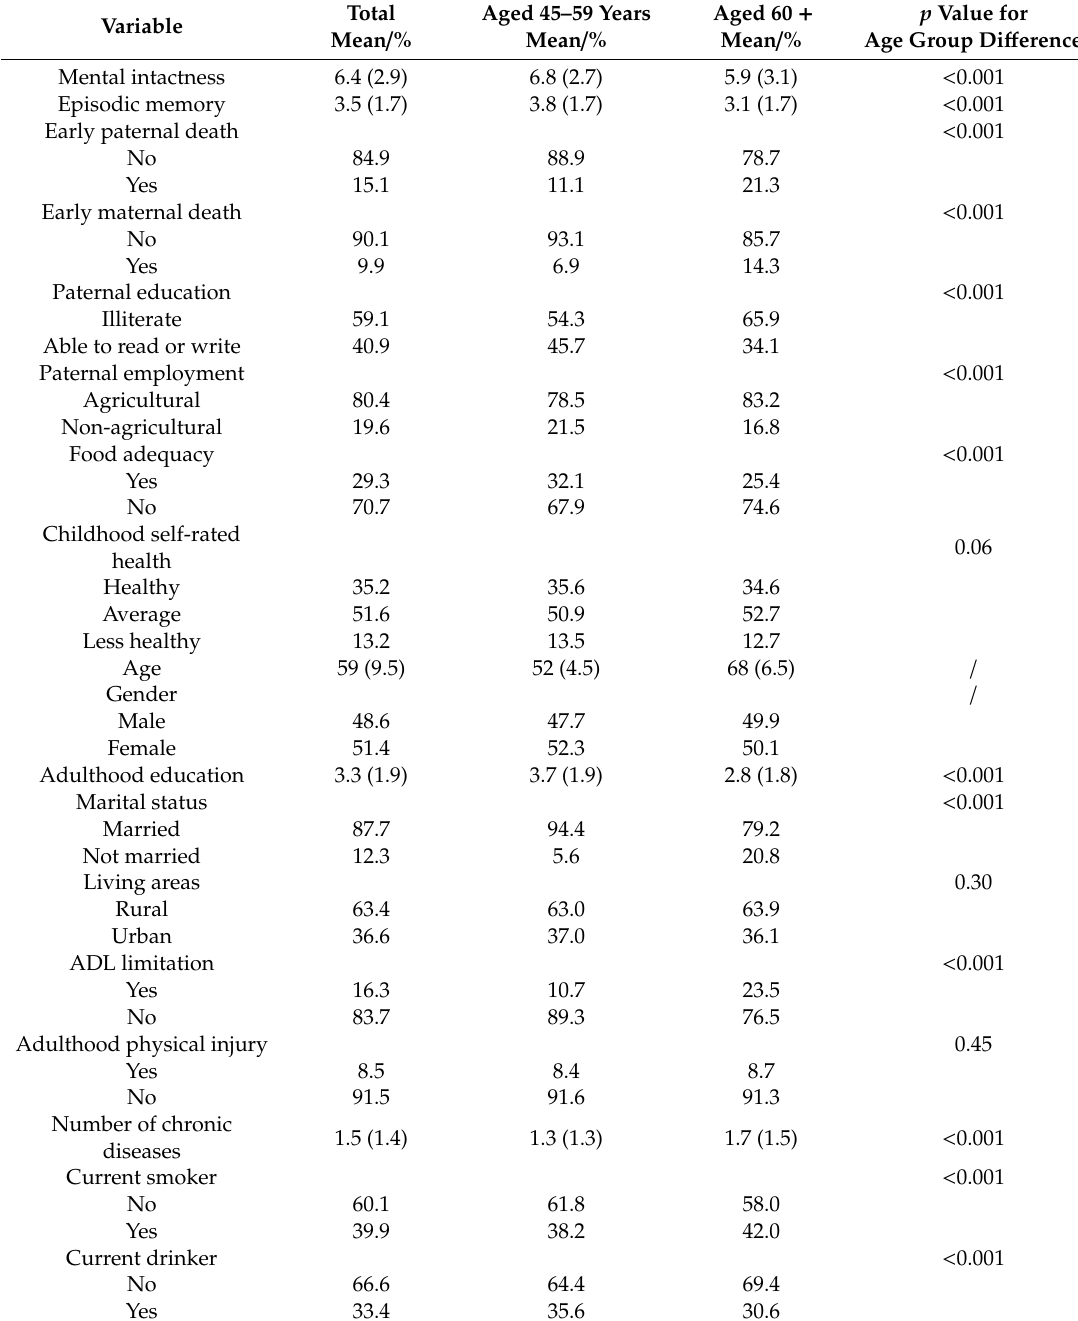
Table 1. Baseline sample descriptive statistics (N =